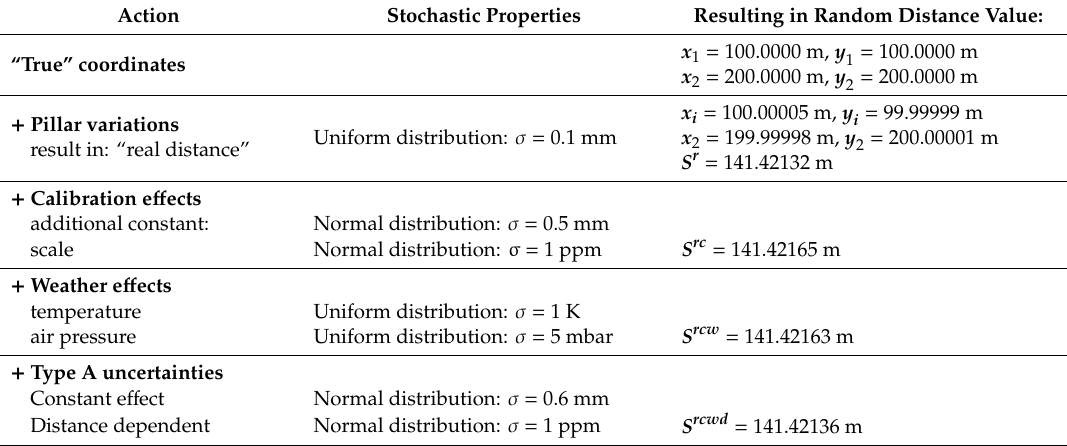
Table 2. Derivation of one input quantity for a distance, using random numbers for some influencing e ff